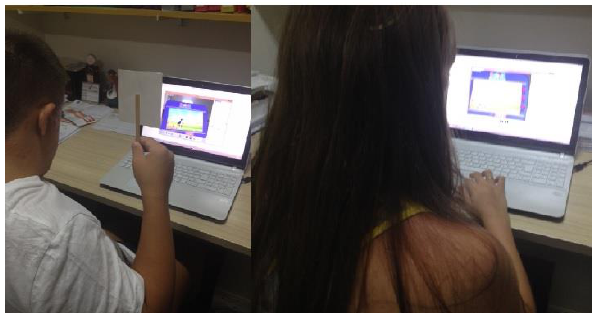
Figure 7. Children using